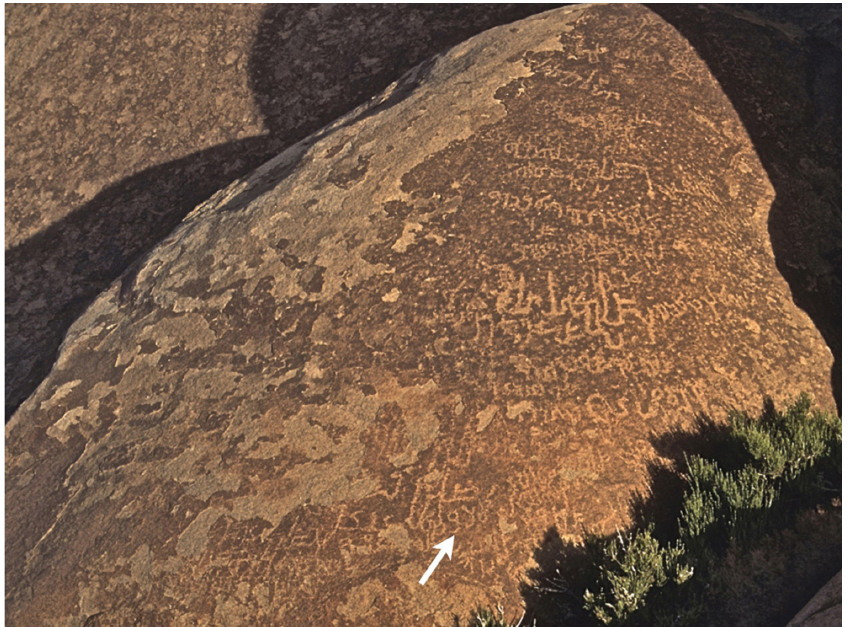
Figure 17 Nabataean inscriptions at the top of Jebel Serbal, the title “ אלפכא ” (high priest) is indi- cated by the